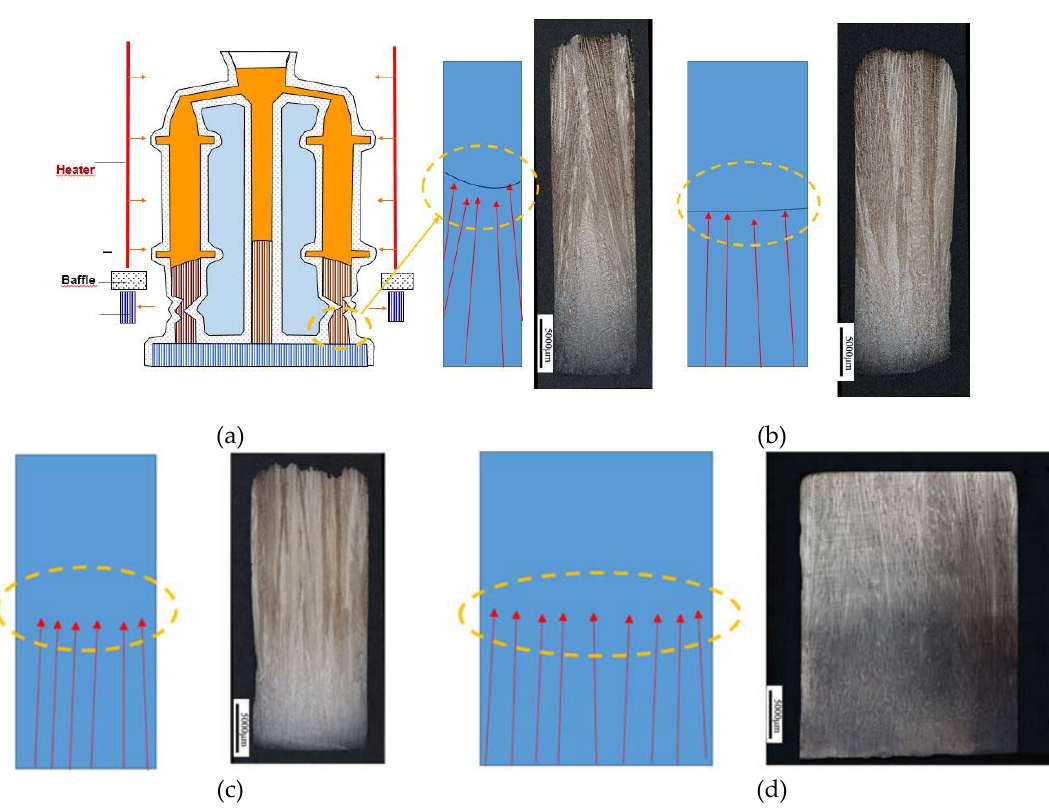
Figure 4. Competitive growth of longitudinal sections of starters with di ff erent width ( a ) 8 mm, ( b ) 10 mm, ( c ) 15 mm, and ( d ) 30